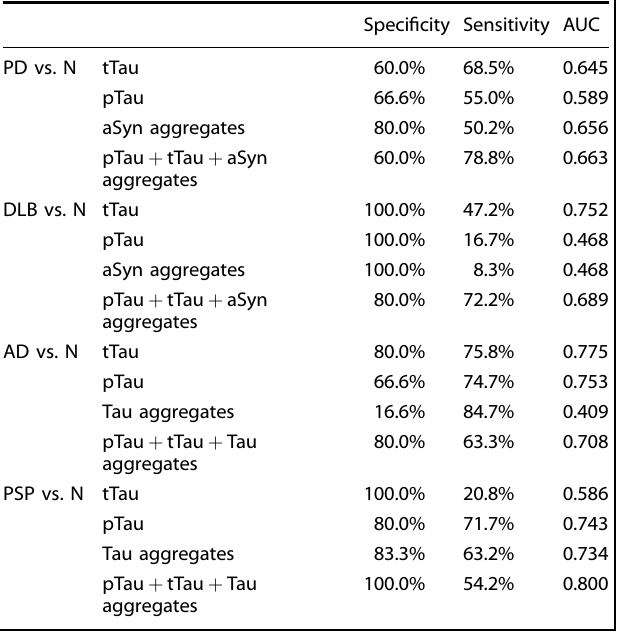
Table 4. Results of ROC analysis for speci fi city, sensitivity and area under the curve (AUC) for pTau, tTau, aSyn or Tau aggregates in CSF and their